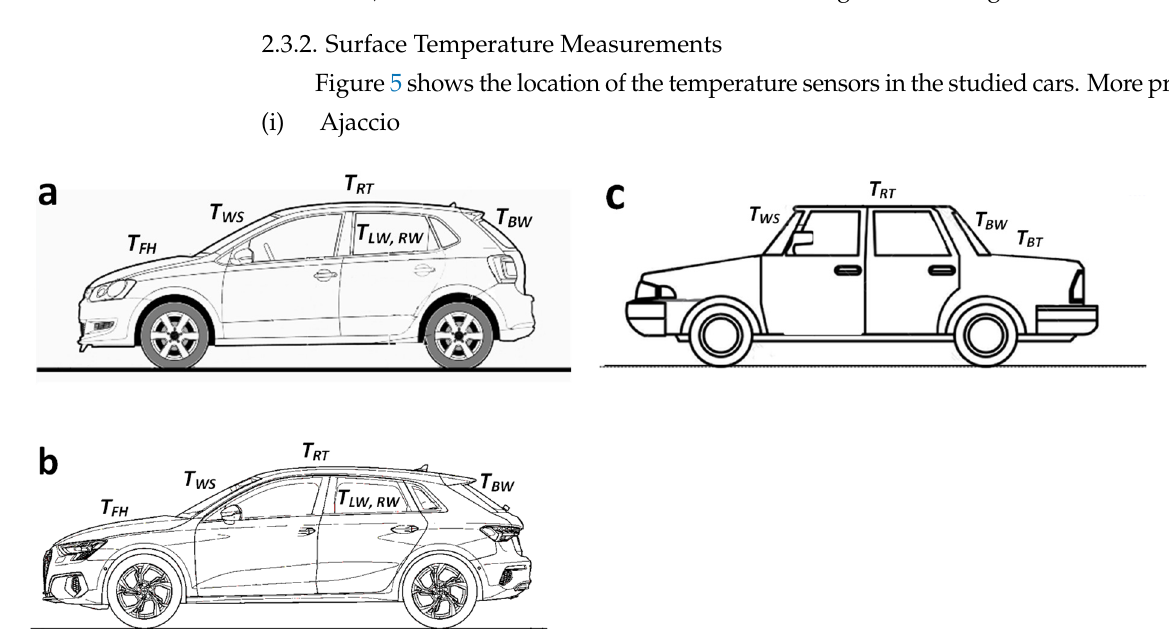
Figure 5. Cars under study with the position of the K-thermocouple sensors. ( a , b ): VW and AD cars (Ajaccio, France); ( c ): DC car (Valparaiso, Chile). (Scale and actual angles are not respected on pic- on tures).